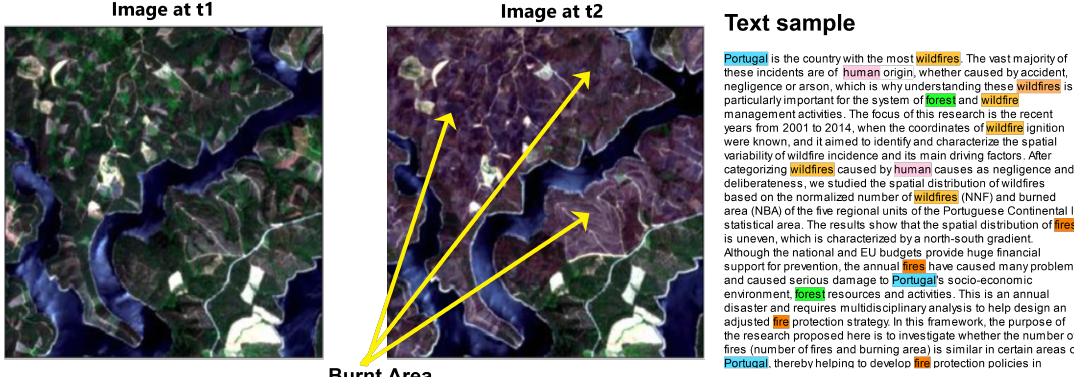
Figure 1. Sample images from the dataset with an example text containing relevant keywords for annotating the images. A pair of images is shown with the first image taken at t1 (14 June 2017), and the second one taken at t2 (4 July 2017) showing apparent burnt areas. A portion of text is shown to illustrate the content of the scientific publications being used, and relevant keywords within the text are